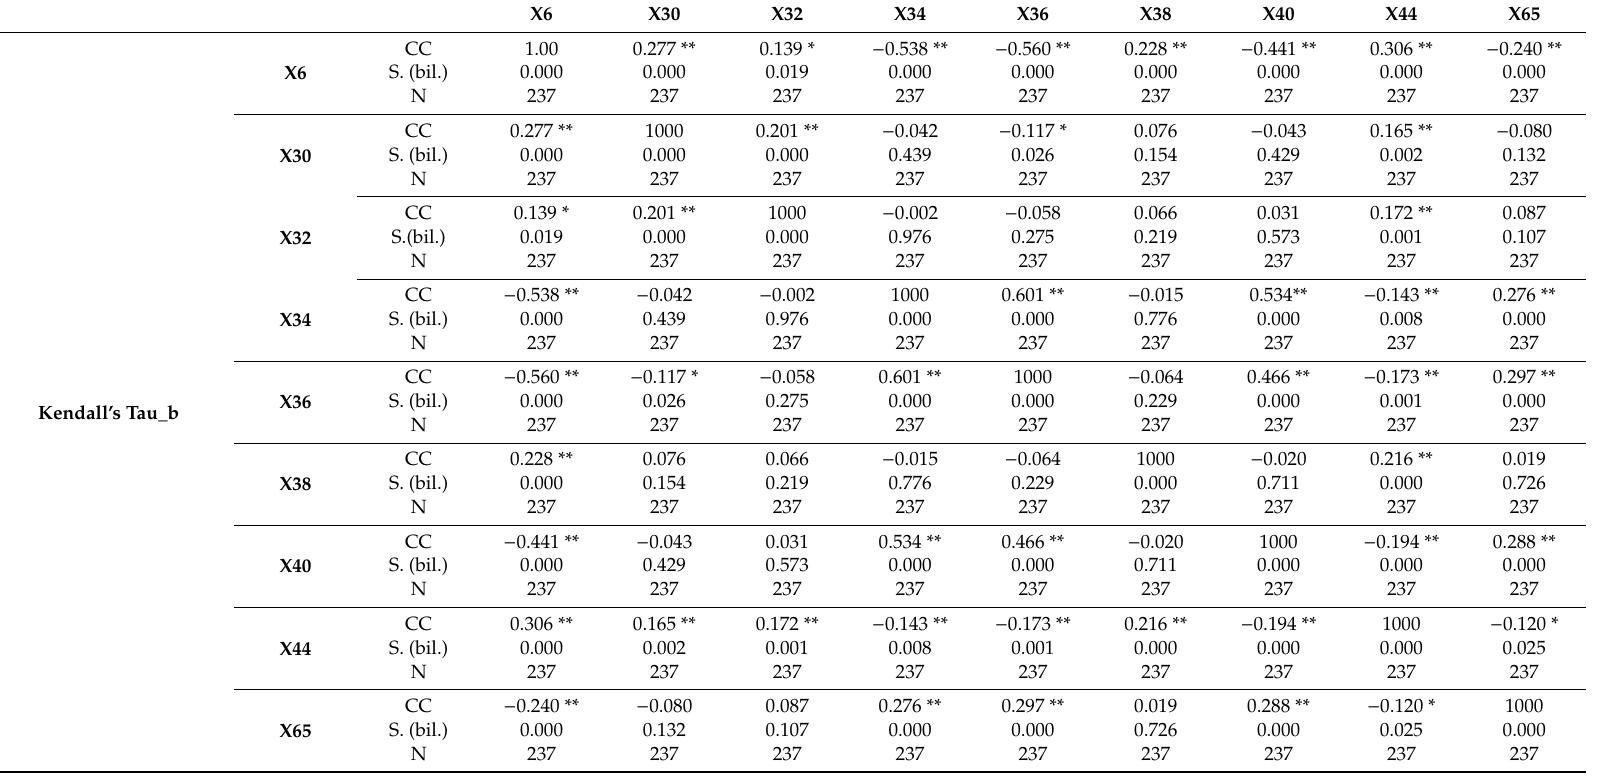
Table 2. Kendall and Spearman’s correlation coe ffi cients (CC) between X6 (gender) and variables X30, X32, X34, X36, X38, X40, X44, and